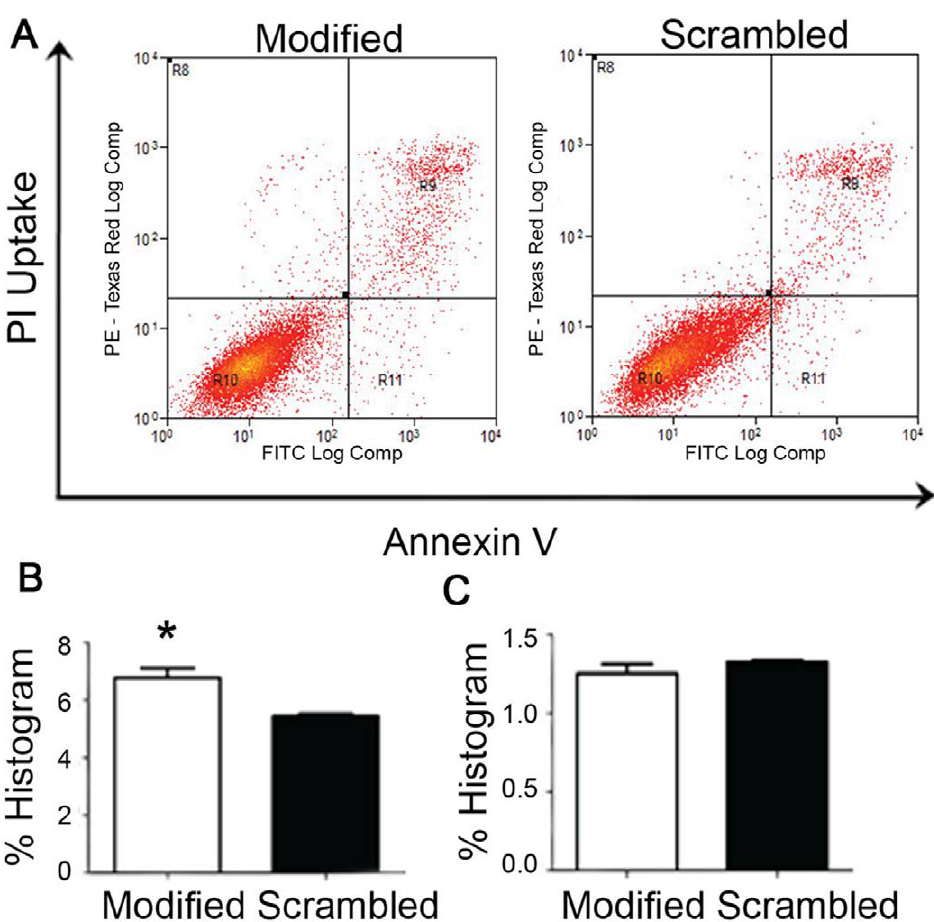
Figure 7. Annexin V assay of Hep G2 cells treated with modified sequence and scrambled sequence. (A) The scatterplot depicting the distribution of cells with annexin V staining along the x-axis and those stained with propidium iodide (PI) along the y-axis. Region R10 denotes the viable population (double negative for annexin V and PI), R9 the non-viable cells (double positive for annexin V and PI), R11 shows the annexin V positive (PI negative) population while R8 are the damaged cells (PI positive but annexin-V negative). (B) % Histogram of the R9 quadrant data. The analysis of the triplicate samples for showed a significantly higher amount of dead cells (p-value , 0.05) in the modified sequence treatment compared to the scrambled sequence control. (C) % Histogram of R11 quadrant data. The results show no significant difference for early apoptosis. Error bars=SEM.